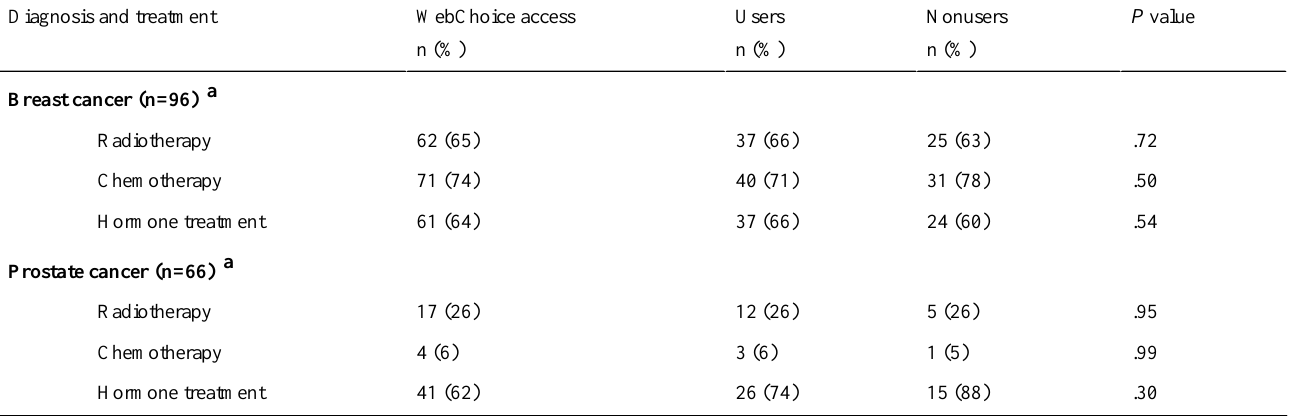
Table 3. Baseline treatment characteristics of patients with access to WebChoice by diagnosis.